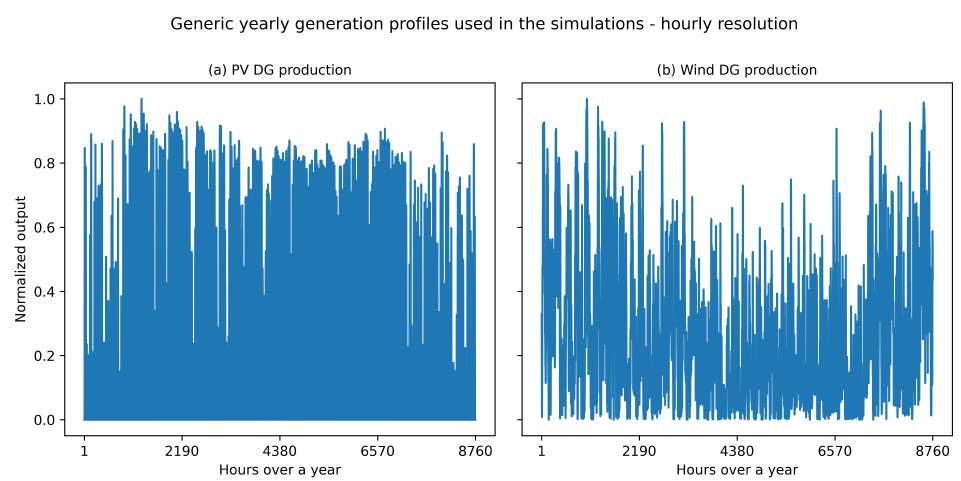
Figure 9. Input data—load shapes: ( a ) PV plant output; ( b ) wind plant